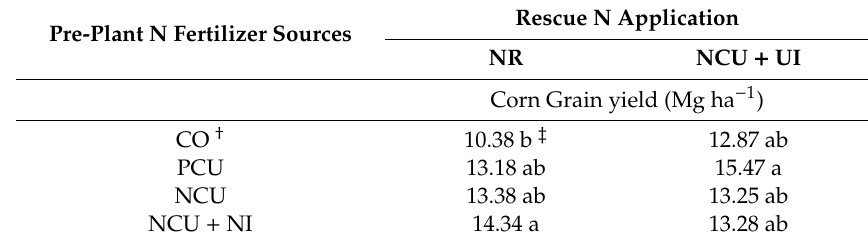
Table 3. Impact of pre-plant N fertilizer sources and post-waterlogging rescue N application on corn grain yield in